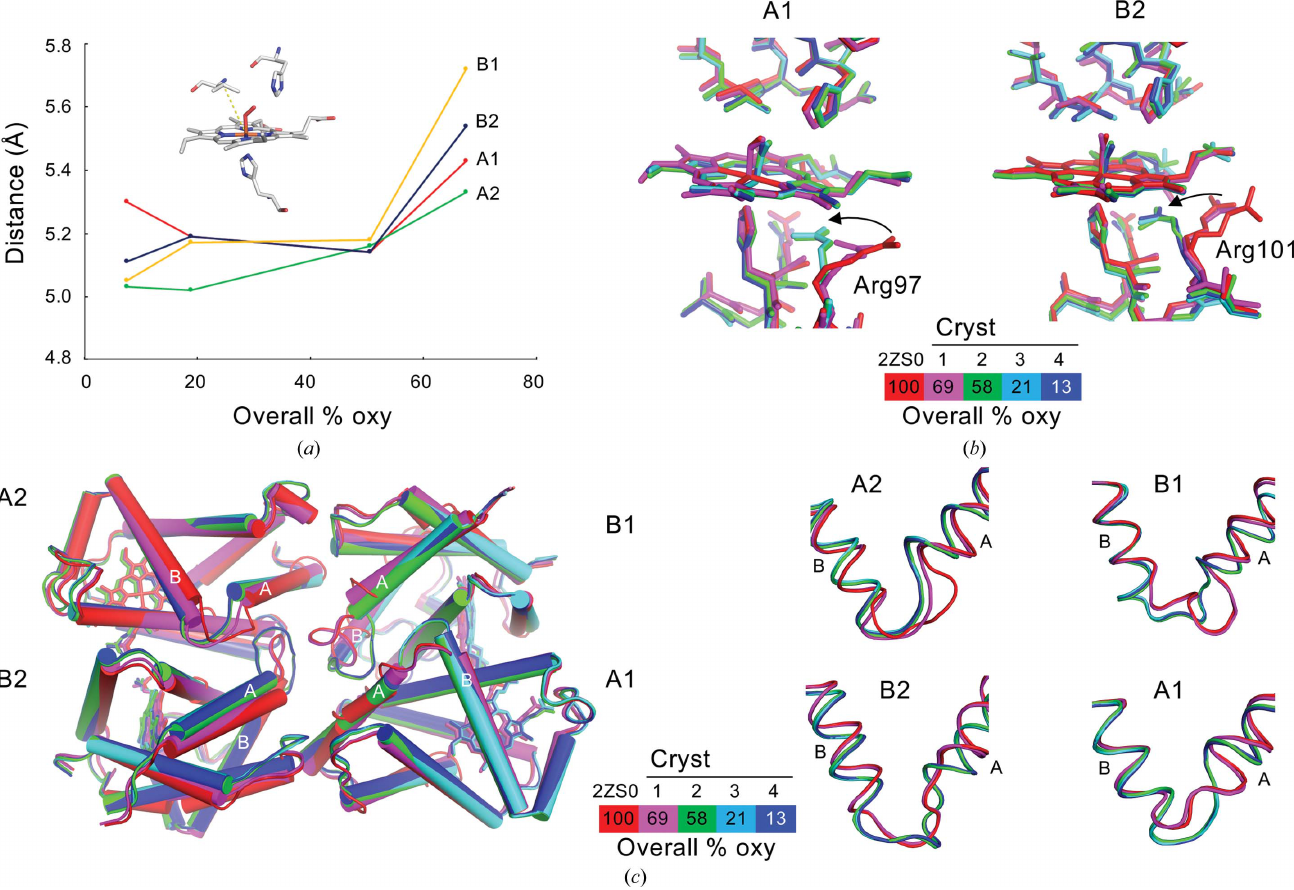
Figure 3 Ternary-structural transitions in each subunit. ( a ) Changes in the distance between the C (cid:3) atom of Val E11 and the iron of the heme (yellow dashed line in the inset) for each subunit. The overall oxygen saturation of the crystals (horizontal axis) was determined as in Fig. 1. ( b ) Superpositions around the heme of the A1 (left) and B2 (right) subunits. The stick models of fully oxygenated Oli Hb (PDB entry 2zs0; Numoto et al. , 2008 a ) and Crystals 1, 2, 3 and 4 are drawn in red, magenta, green, cyan and blue, respectively. The conformational changes in A1 Arg97 and B2 Arg101 are indicated by black arrows. ( c ) Superpositions of the tetrameric subassemblies. The color schemes are the same as in ( b ). The A and B helices of each subunit are labeled. Close-up views of the superpositions of the AB loops are shown in the right